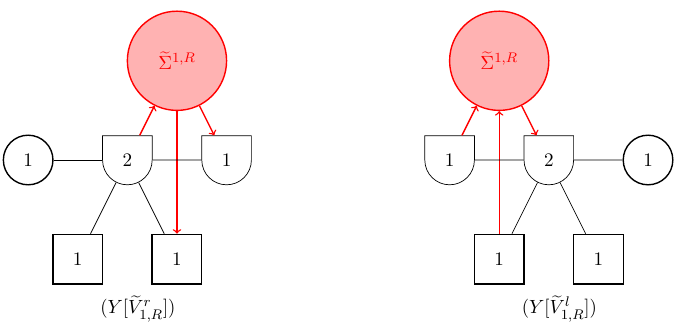
Figure 29 . A family of vortex defects e V 1 ,R in the theory Y and the associated 3d-1d coupled